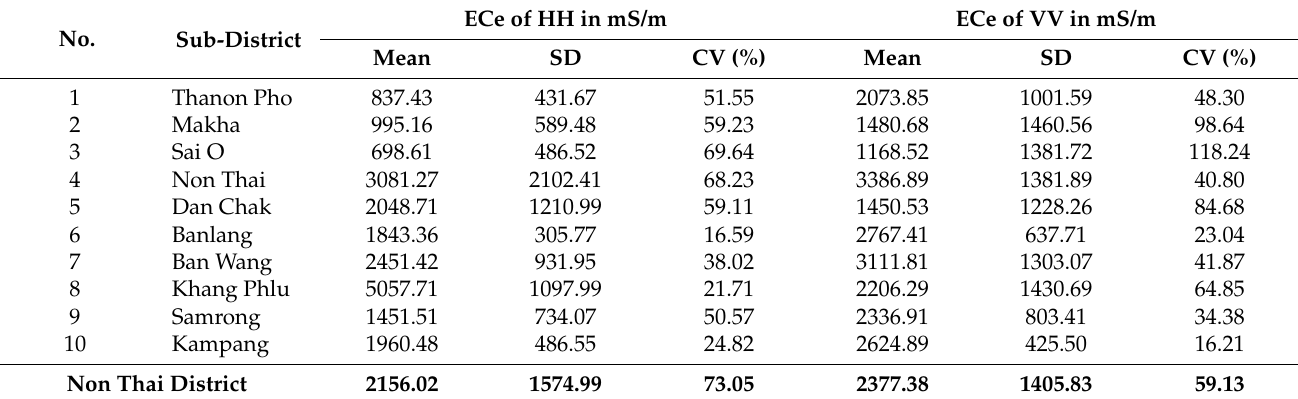
Table 14. Statistical data of soil salinity prediction using RK of two measuring modes by sub-district.